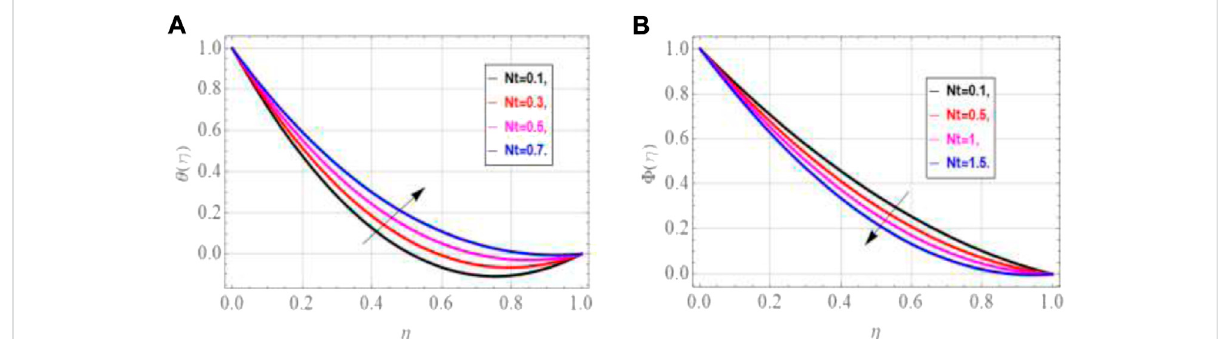
FIGURE 7 Impact of Nt on θ ( η ) , Φ ( η ) .